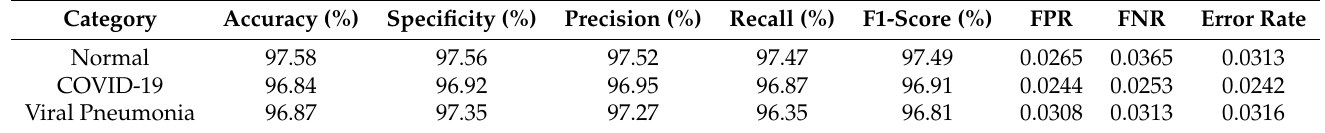
Table 8. Performance measures for ResNet-50 without optimization for X-ray